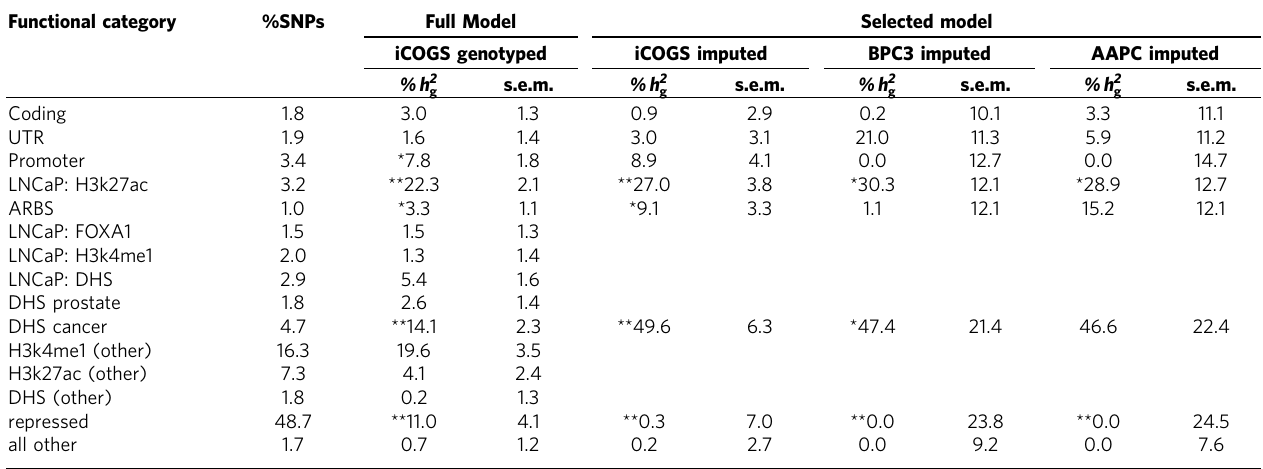
Table 1 | Partitioning of heritability across functional classes in prostate cancer. Functional